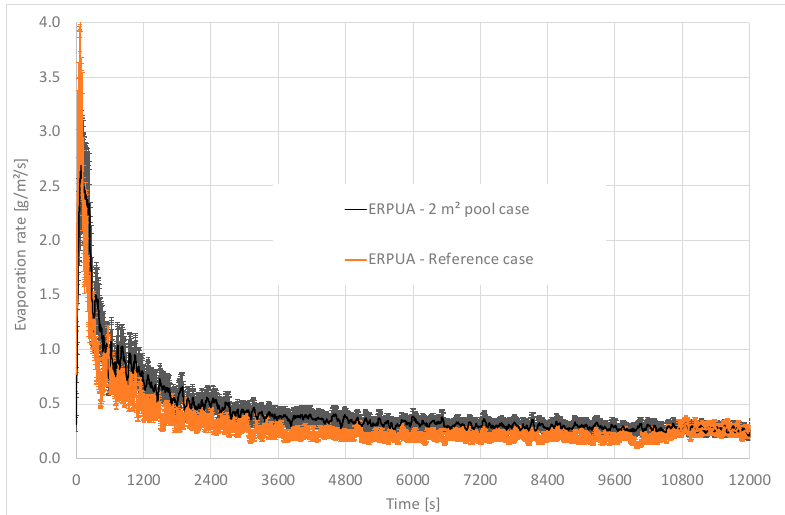
Figure 12. Evolution of the evaporation rate as a function of the exposed pool length.